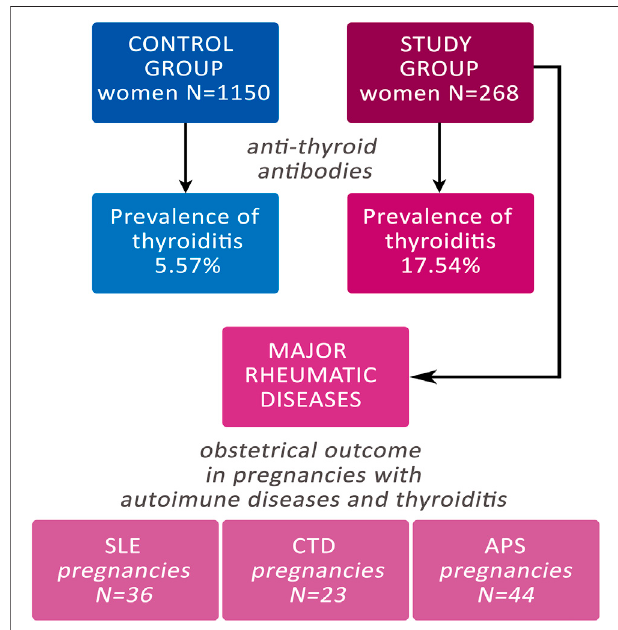
FIGURE 1 | Flow-chart of the study. CTD: Connective Tissue Diseases; SLE: Systemic Erythematosus Lupus; APS: Anti-Phospholipid